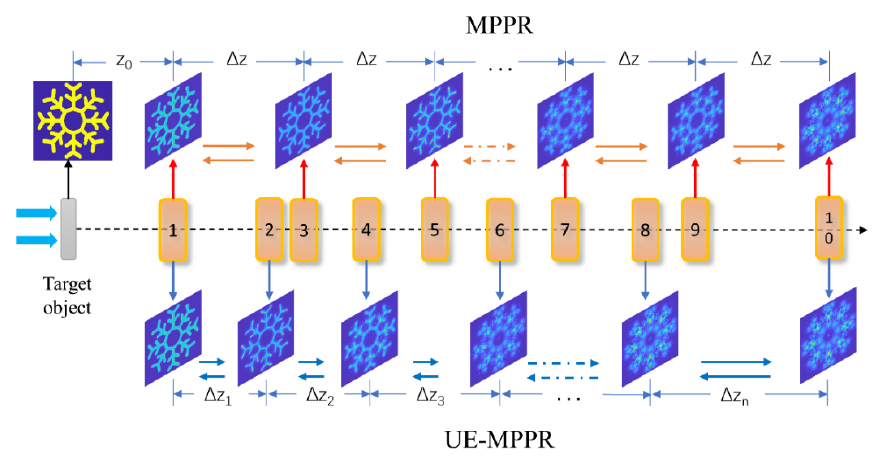
Figure 1. The schematic diagram for the multiple-plane phase retrieval method. Yellow arrows depict the flow of the conventional reconstruction algorithm, blue arrows depict the flow of the proposed algorithm with unequal spaced measurement.